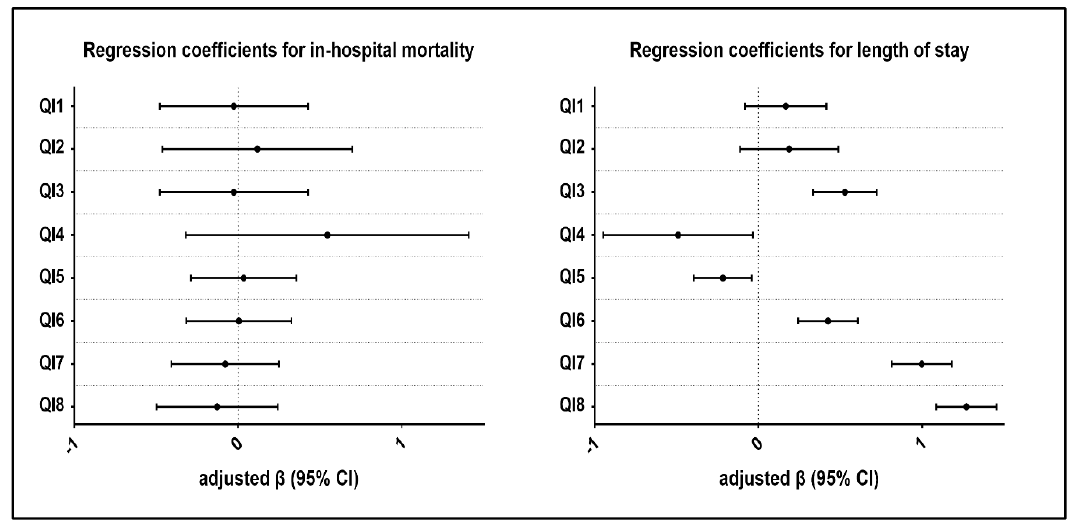
Figure 1. Regression coefficients estimation for in-house mortality and length of